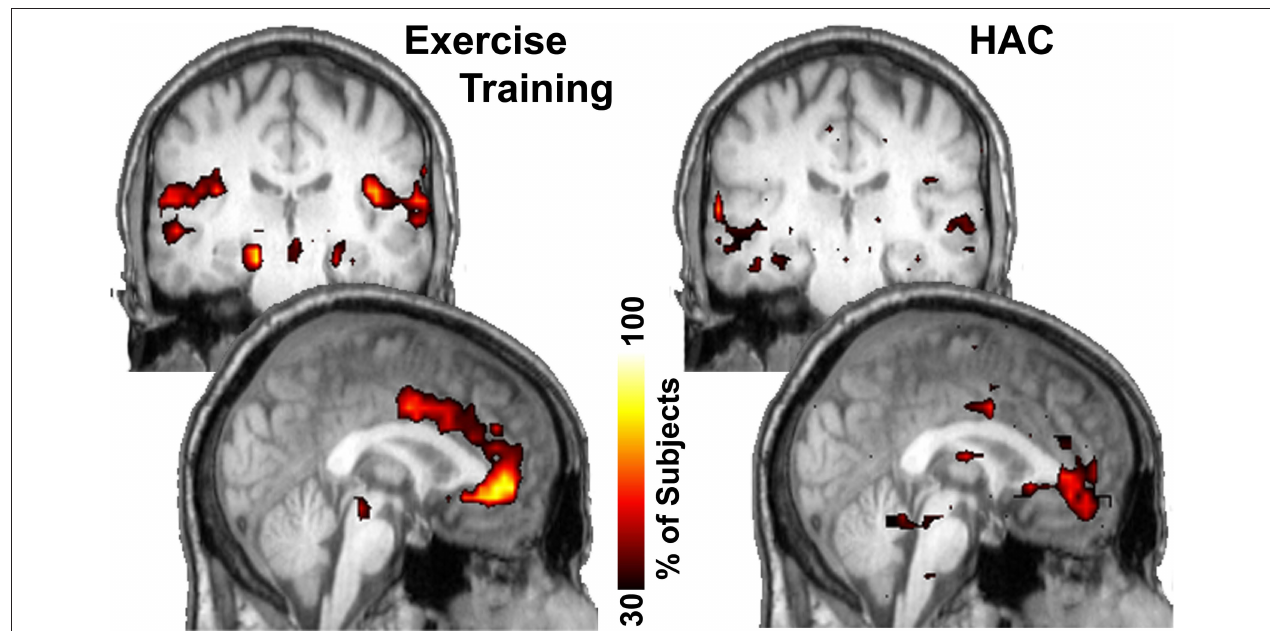
the anterior cingulate only has minor connections with the hippocampus. Color bar shows the percentage of subjects that have each voxel in this network